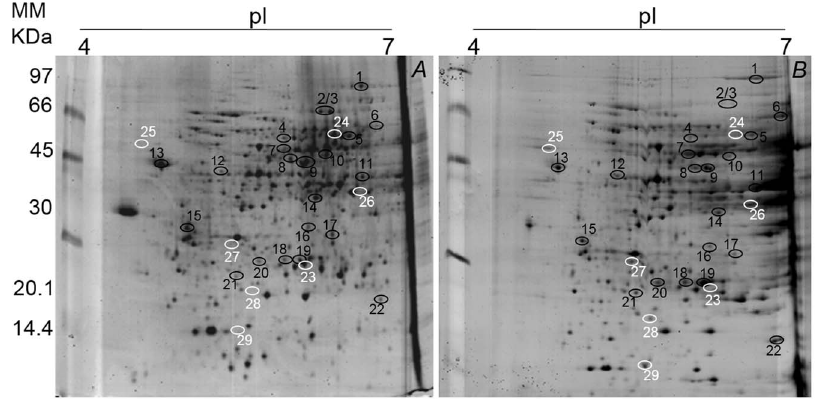
Figure 5. Two-dimensional gel of proteins from roots of the TSA-792 clonal genotype of Theobromacacao subjected to 96 h of soil flooding. A - control and B - flooded. Each gel was loaded with 350 g of total protein and stained with 0.08% w/v colloidal Coomassie G-250. Black circles indicate spots differentially expressed between control and flooded treatments, whereas white circles indicate spots exclusive to one of the treatments in response to soil flooding.